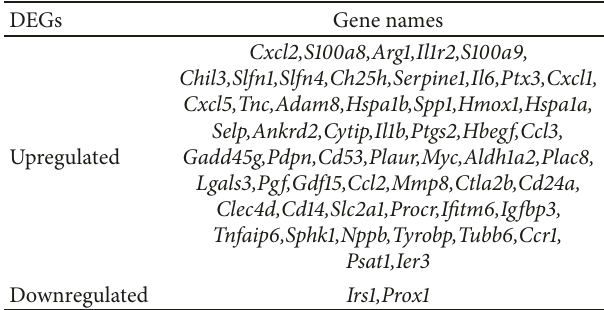
Table 2: Screening DEGs in AMI by integrated